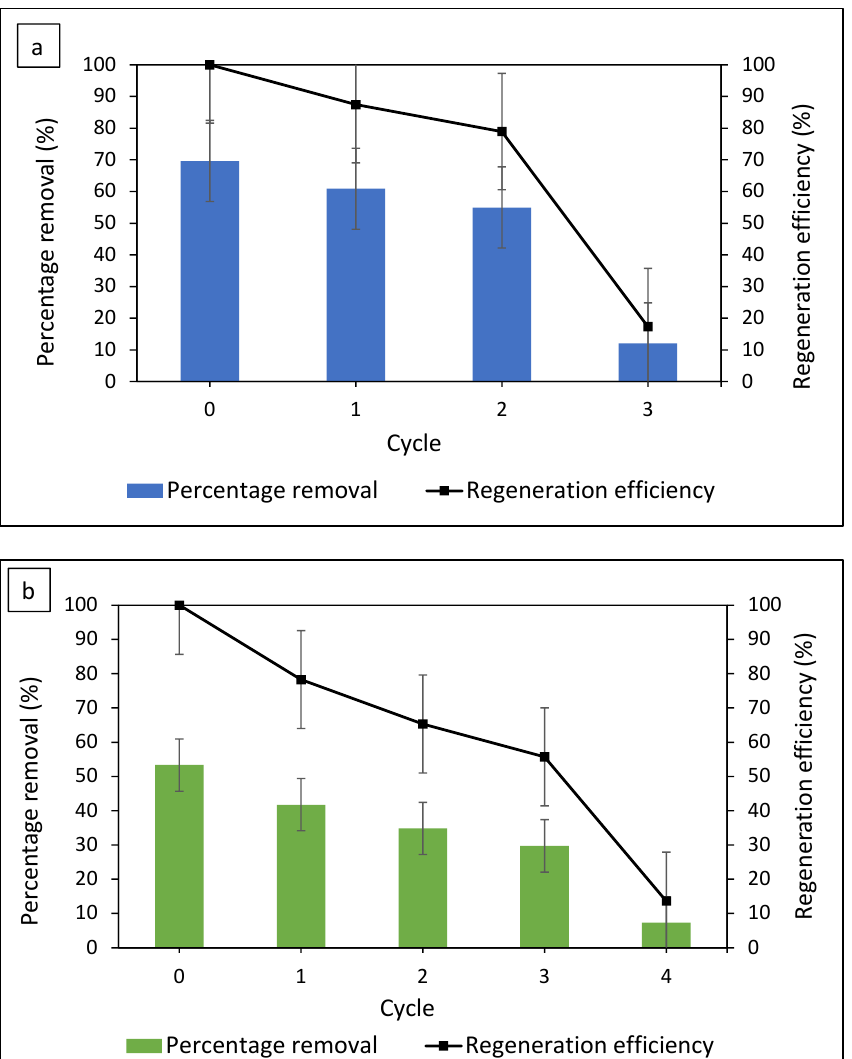
Figure 12. The regeneration cycle of the FMS/PU composite for ( a ) MB and ( b ) MG. XRD analysis was carried out on spent FMS/PU to observe any change in the crystallinity of the composite. Figure 13 shows a comparison of the XRD patterns of FMS/PU, FMS/PU — MB, and FMS/PU — MG. A significant change was not observed in any XRD patterns due to the amorphous state of FMS/PU. Hence, the XRD pattern proves that the FMS/PU retains its stability after the adsorption of MB and MG.